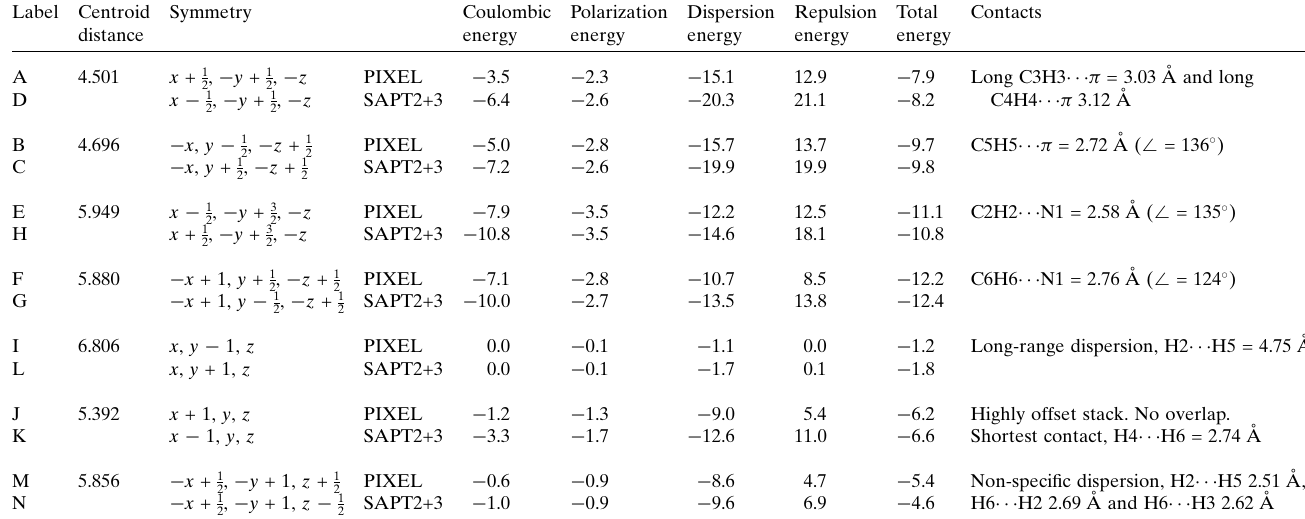
Table 3 Intermolecular contacts in pyridine II. All energies are in kJ mol (cid:5) 1 and contact distances (in A˚ ) were calculated with C—H distances reset to 1.089 A˚ . Label Centroid Symmetry Coulombic distance